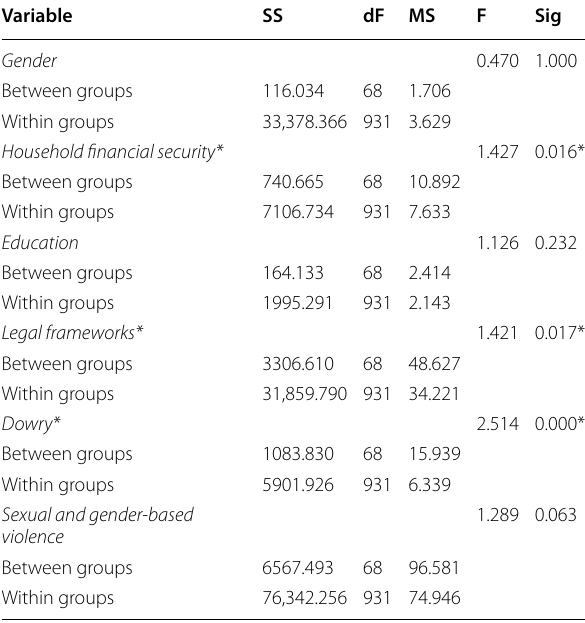
Table 5 Analysis of variance (ANOVA)